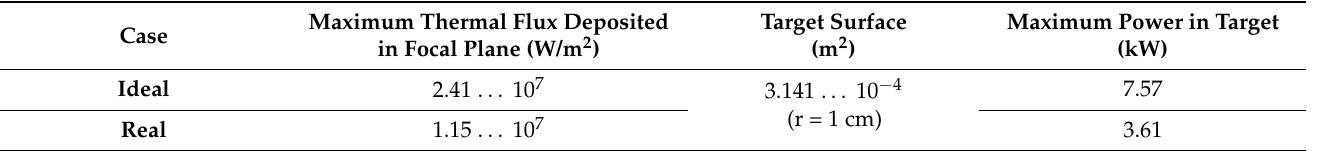
Table 2. Maximum thermal flow values deposited in focal plane of receiver and relative maximum power in target assessed assuming area of concentration with radius equal to 1